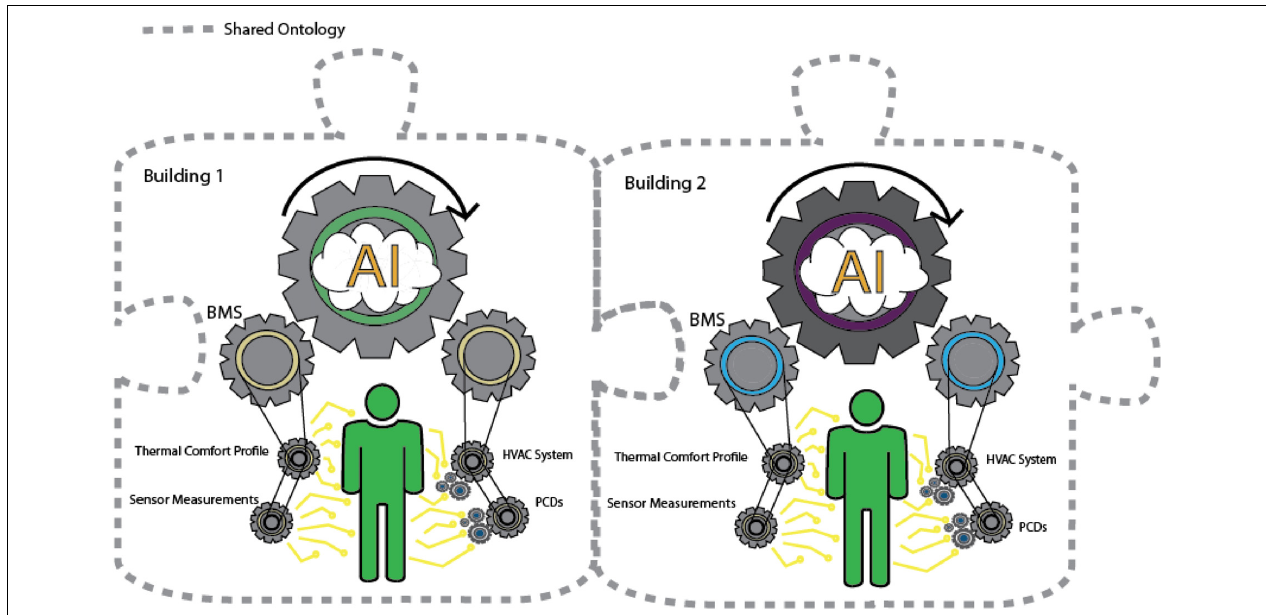
FIGURE 10 | Buildings operating under the same ontology can become compatible in delivering and maintaining building occupant thermal comfort despite differences in HVAC operations.